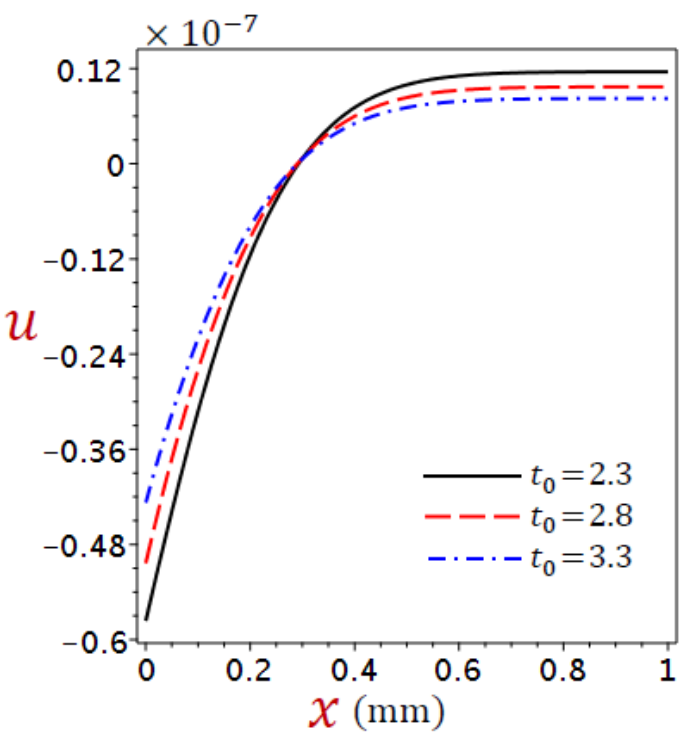
Figure 7. Variation of displacement (𝑢) across the skin tissue using numerous values of the ramp-time parameter for the refined DPL model.